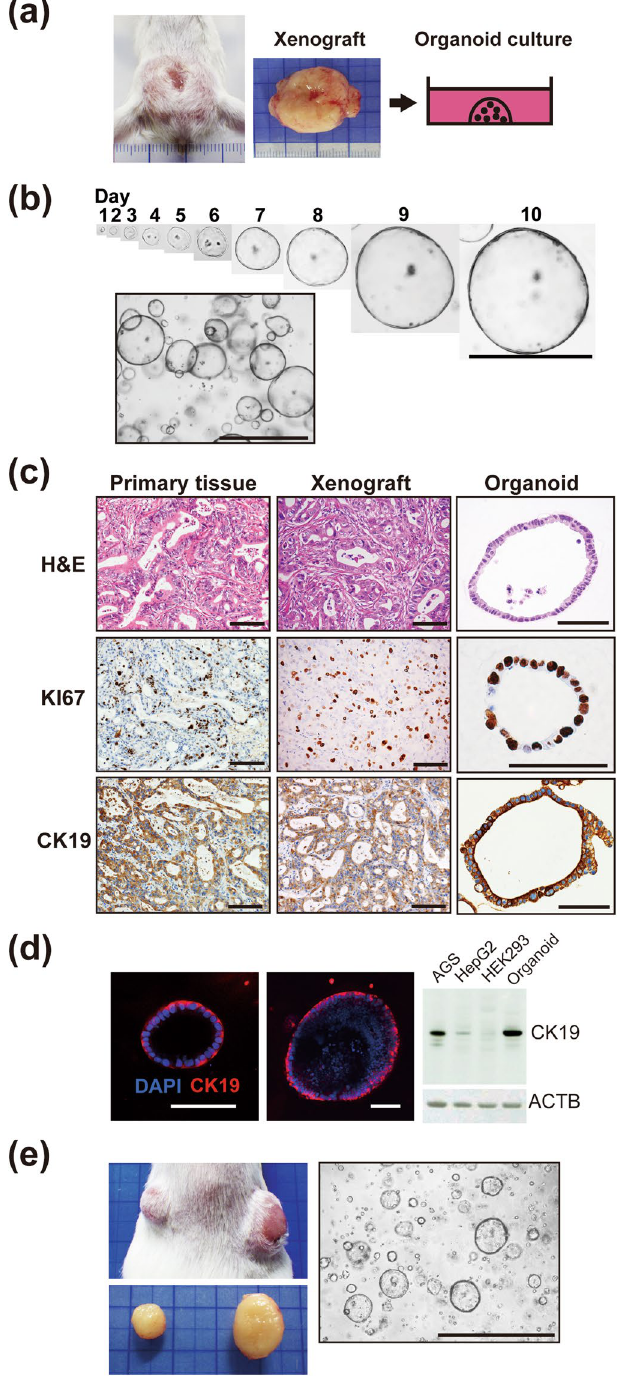
Figure 1. Establishment and long-term in vitro culture of organoids derived from human IHCC. ( a ) Macroscopic features of the human IHCC xenograft that had been implanted subcutaneously into a SCID mouse for approximately 3 months. The xenografted tumor was then excised and subsequently subjected to organoid culture. ( b ) Representative serial images of a single cholangiocarcinoma stem cell expanding into cystic organoids, and bright-field images of IHCC organoids. Scale bars: 1000 μ m. ( c ) H&E, KI67 and CK19 staining of the primary tissue, xenograft and organoid derived from IHCC. Scale bars: 100 μ m. ( d ) Immunofluorescence staining of CK19 (red) in IHCC organoids. DNA is stained with DAPI (blue). Scale bars: 100 μ m (left and middle). Western blotting of CK19 in IHCC organoids and the AGS, HepG2 and HEK293 cell lines. β -Actin (ACTB) was used as an internal control (right). ( e ) Subcutaneous implantation of IHCC organoids into a SCID mouse (right: 8 × 10 5 cells, left: 3 × 10 5 cells). Two months after implantation, the tumors were excised and further subjected to organoid culture. Scale bar: 1000 μ